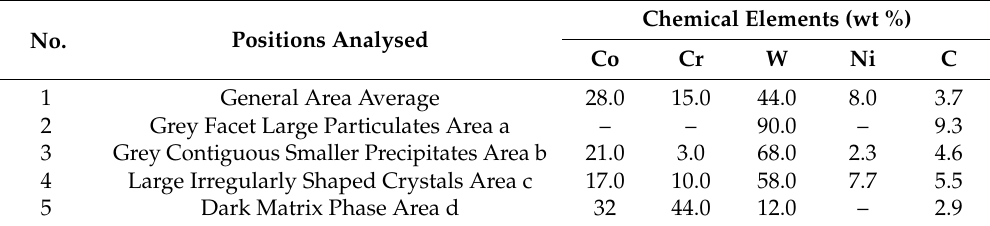
Table 6. Compositions of different areas in the produced sleeve-pipe surface coatings by EDS.